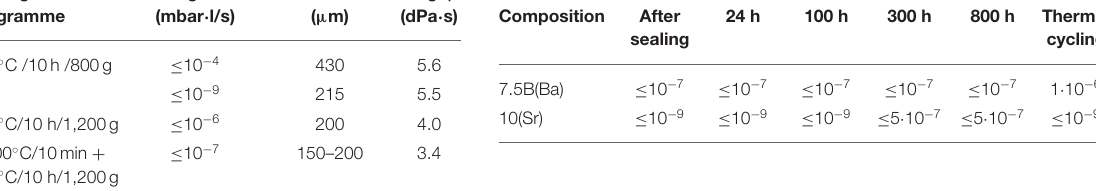
TABLE 1 | Sealing in air, gas-tightness, and final thickness of the joints steel/glass-ceramic/steel. Composition Sealing programme